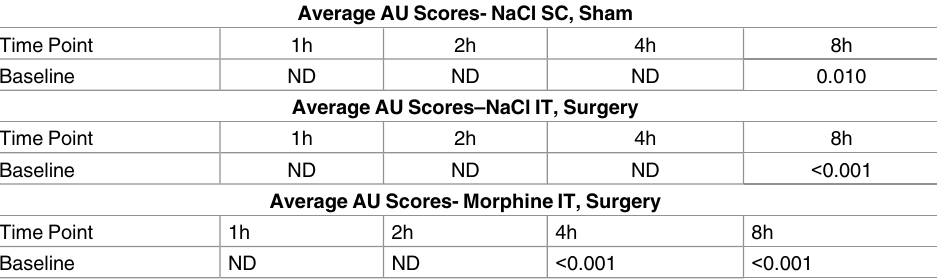
Table 6. Within-subjects comparison between post treatment time-points with baseline with associ- ated p -values for differences where significance was found (Phase 2 of the study). Differencesare